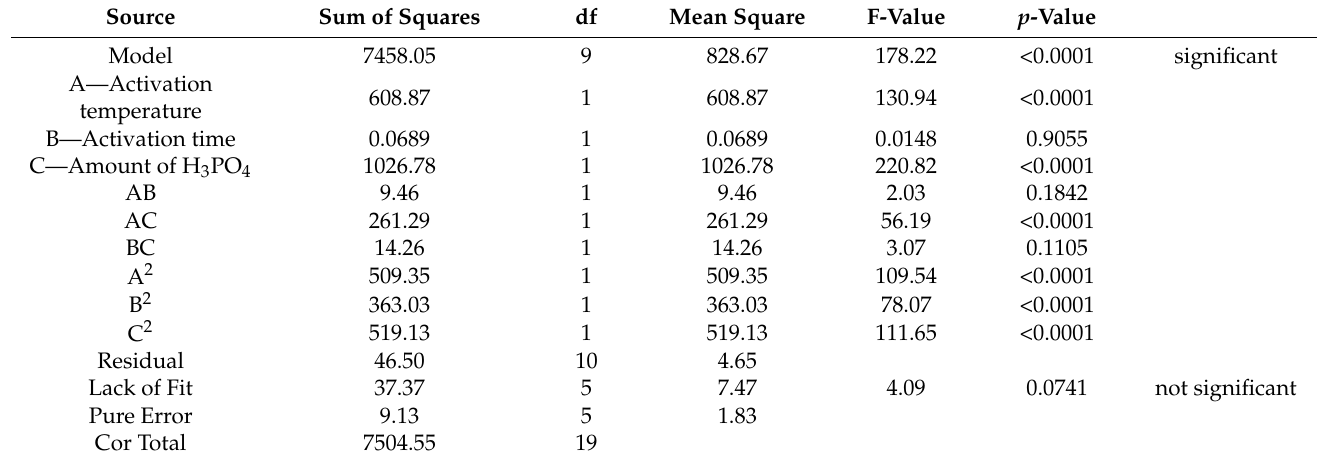
Table 6. ANOVA of the second-order polynomial equation for RY 145 dye